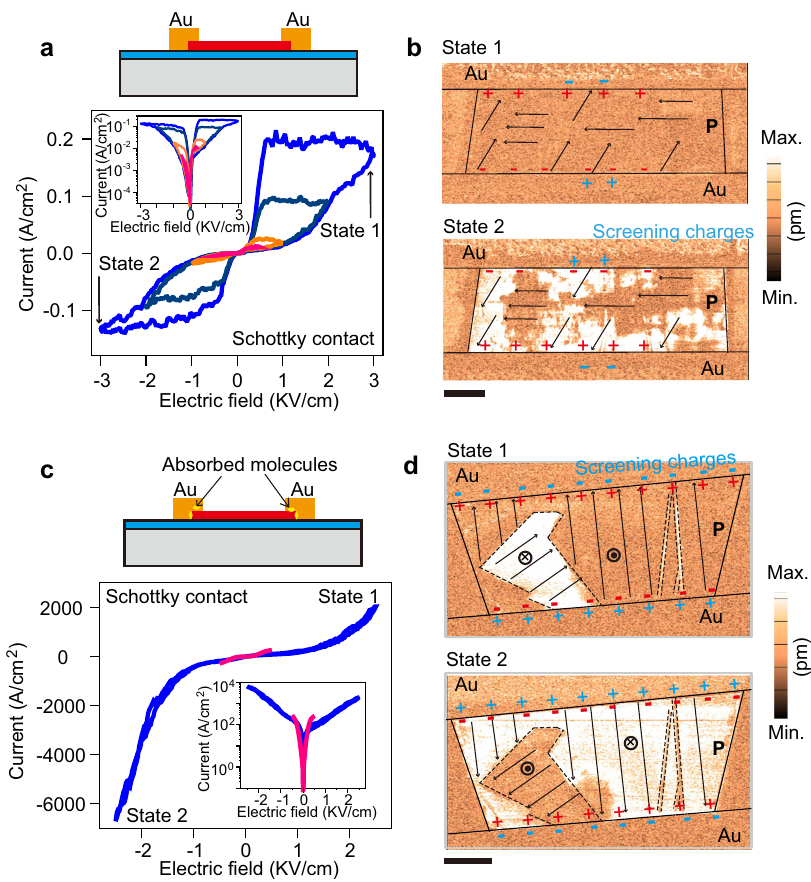
Fig. 4 Schottky-contacted ferroelectric devices. a Cross-sectional illustration of Dev. 3 metalized by high-work-function gold (top panel; Schottky contact device), and its corresponding pinched hysteretic loops (bottom panel). The inset at the bottom shows a logarithmic plot of the loops. Colors from pink to blue indicate electric fi eld sweeping of 0.5, 1, 2, and 3 KV/cm. b PFM amplitude mapping of Dev. 3 with state 1 and state 2. Scale bar: 500 nm. c A Schottky- contacted ferroelectric device with fully screened polarization charges (Dev. 4). The inset at the bottom panel shows electrical curves in logarithmic coordinates in a longitudinal direction. Red and blue curves represent 0.5 and 3 KV/cm sweeping. d PFM amplitude mapping of Dev. 4 for state 1 and state 2. Scale bar: 1 μ m. For comparison, incompletely and completely screening charges are all labeled in b and d by